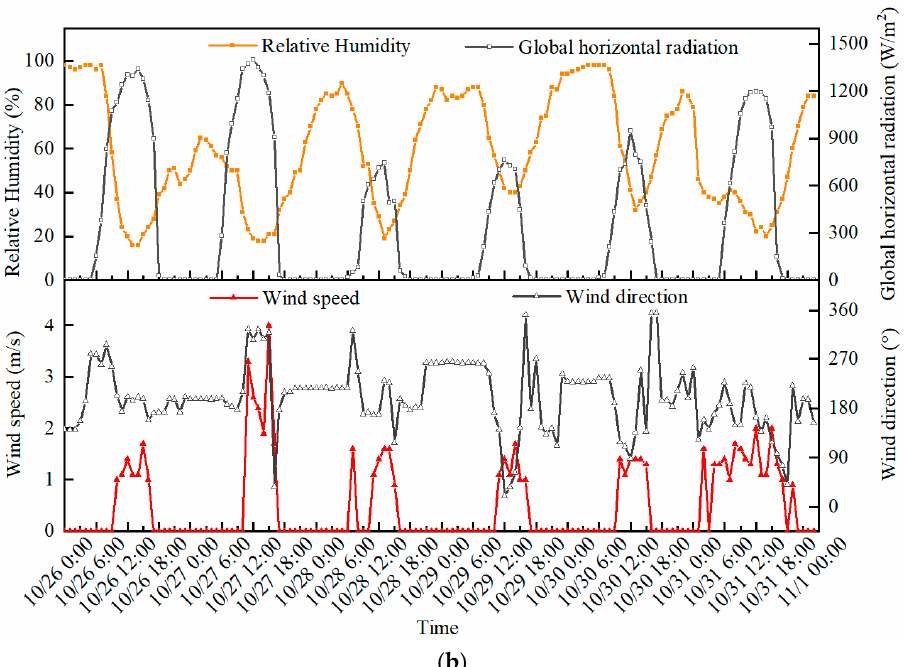
Figure 10. ( a ) Indoor air temperature profile compared between simulation and experimental results and the associated ( b ) outdoor weather data during a week in October